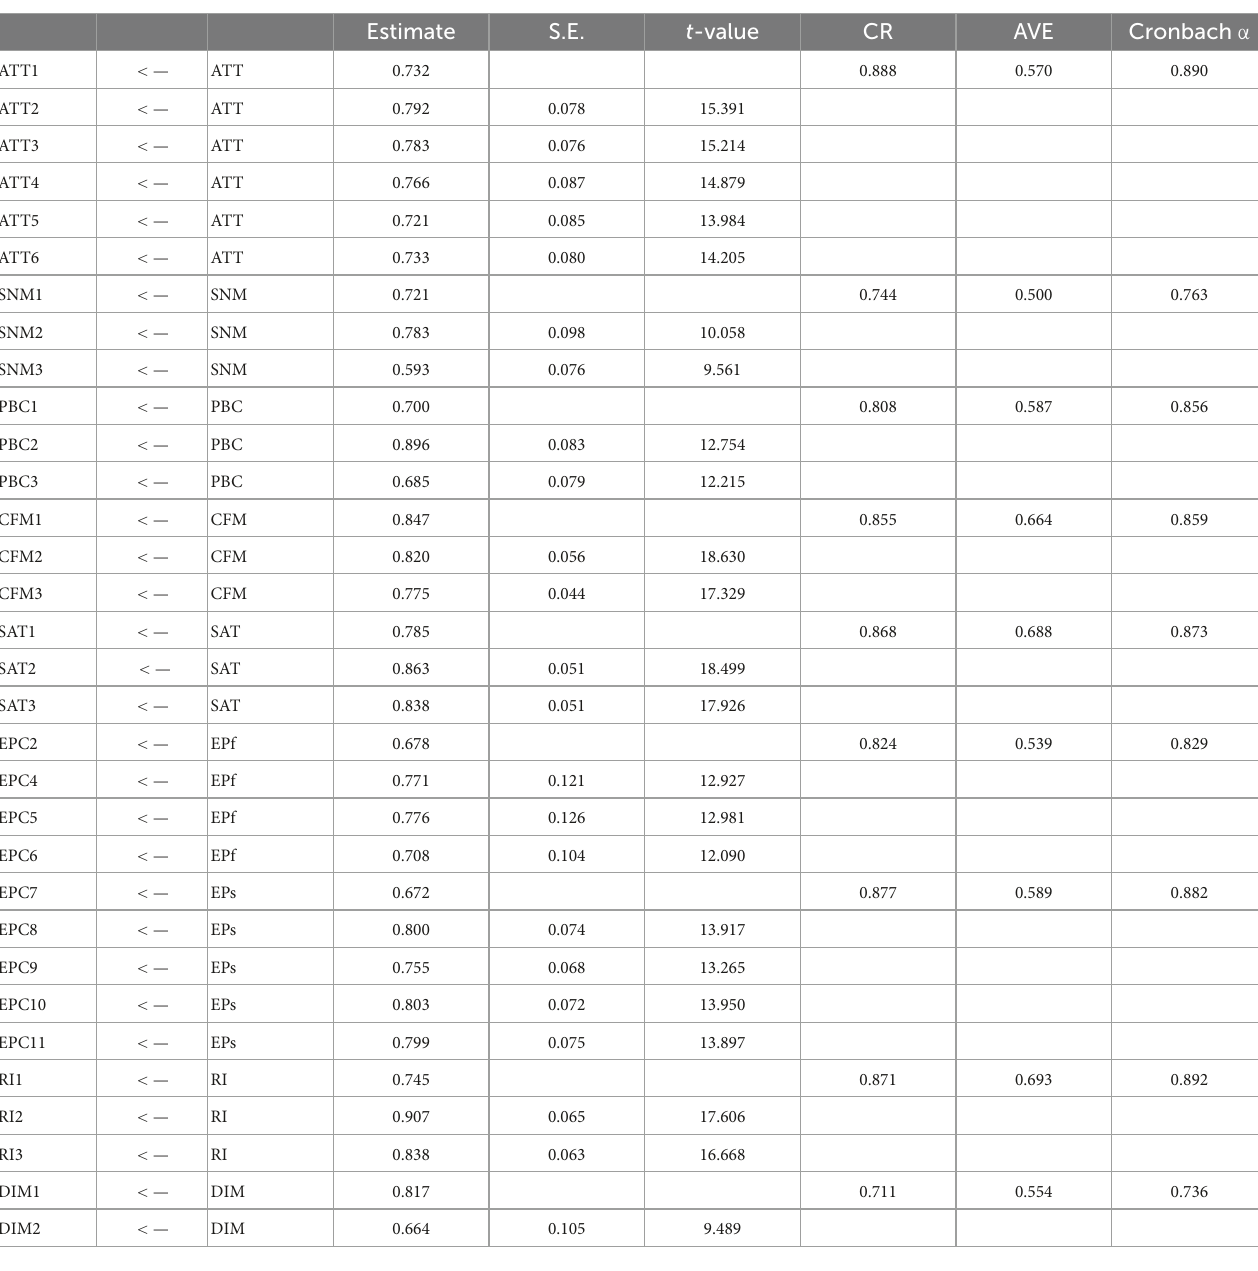
TABLE 4 Confirmatory Factor Analysis (CFA) analysis results.